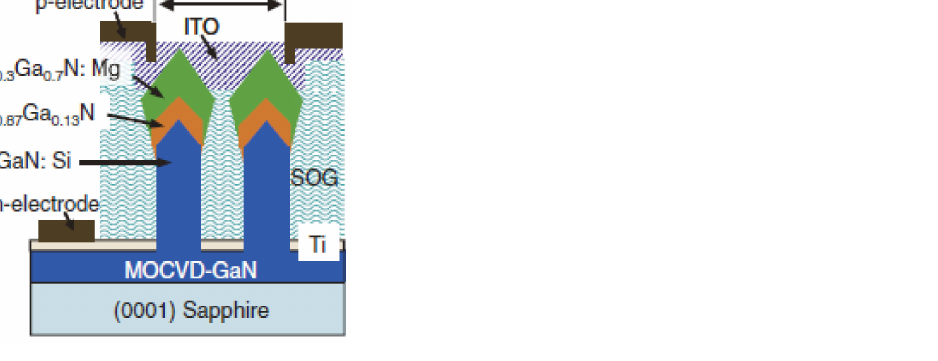
Figure 15. Schematic of the LED structure on the sapphire. Reproduced from [140], with permission from Copyright The Japan Society of Applied Physics,